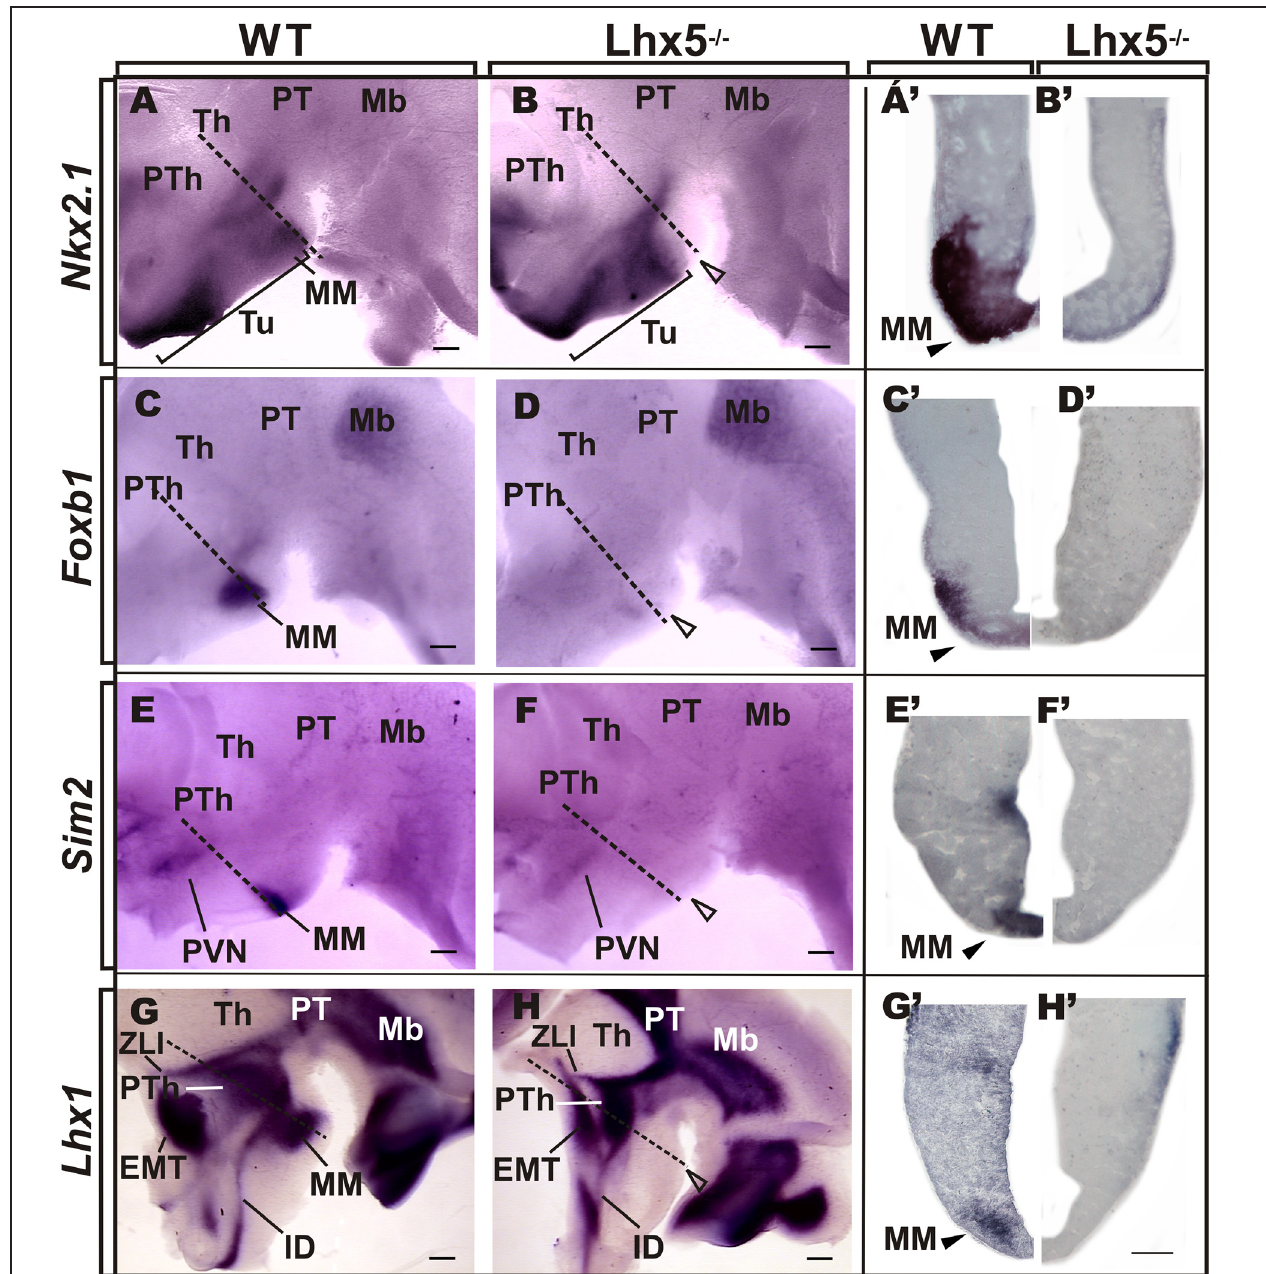
FIGURE 3 | Comparative analysis of MM markers in the developing embryo. Genetic expression profile of Nkx2.1, Foxb1 , Sim2 , and Lhx1 in the prospective MM in E12.5 preparations of whole-mount (A–H , anterior is to the left) and coronal sections (A’–H’) of corresponding Lhx5 mutant and control embryos, as indicated. Empty arrowheads point to the approximate location of MM in Lhx5 mutants. Dashed lines in (A–H) indicate the approximate plane of sections shown in (A’–H’) . Brackets in (A,B) demarcate the extent of Nkx2.1 expression along the anterio-posterior axis. Abbreviations: Th, thalamus; EMT, eminentia thalami; IDv, ventral intrahypothalamic diagonal; Mb, midbrain; MM, mamillary; PVN, paraventricular nucleus; PT, pretectum; PTh, prethalamus; Tu, tuberal; ZLI, zona limitans intrathalamica. Scale bars: (A–H) 400 µ m, (A’–H’) 200 µ m.